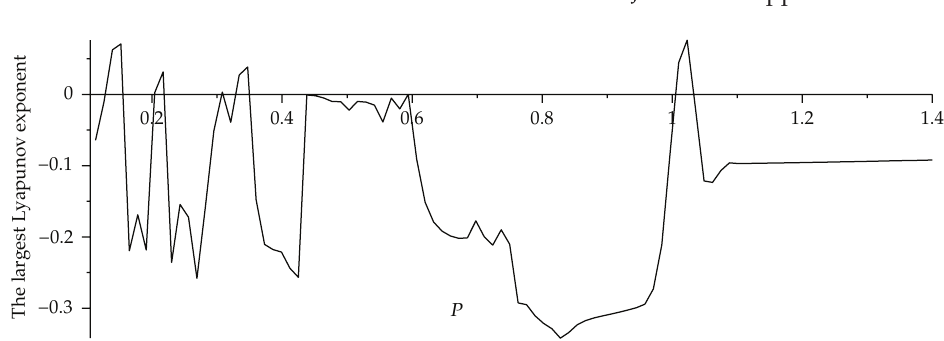
Figure 9: The largest Lyapunov exponents (cid:2) LLE (cid:3) corresponding to Figure 4.